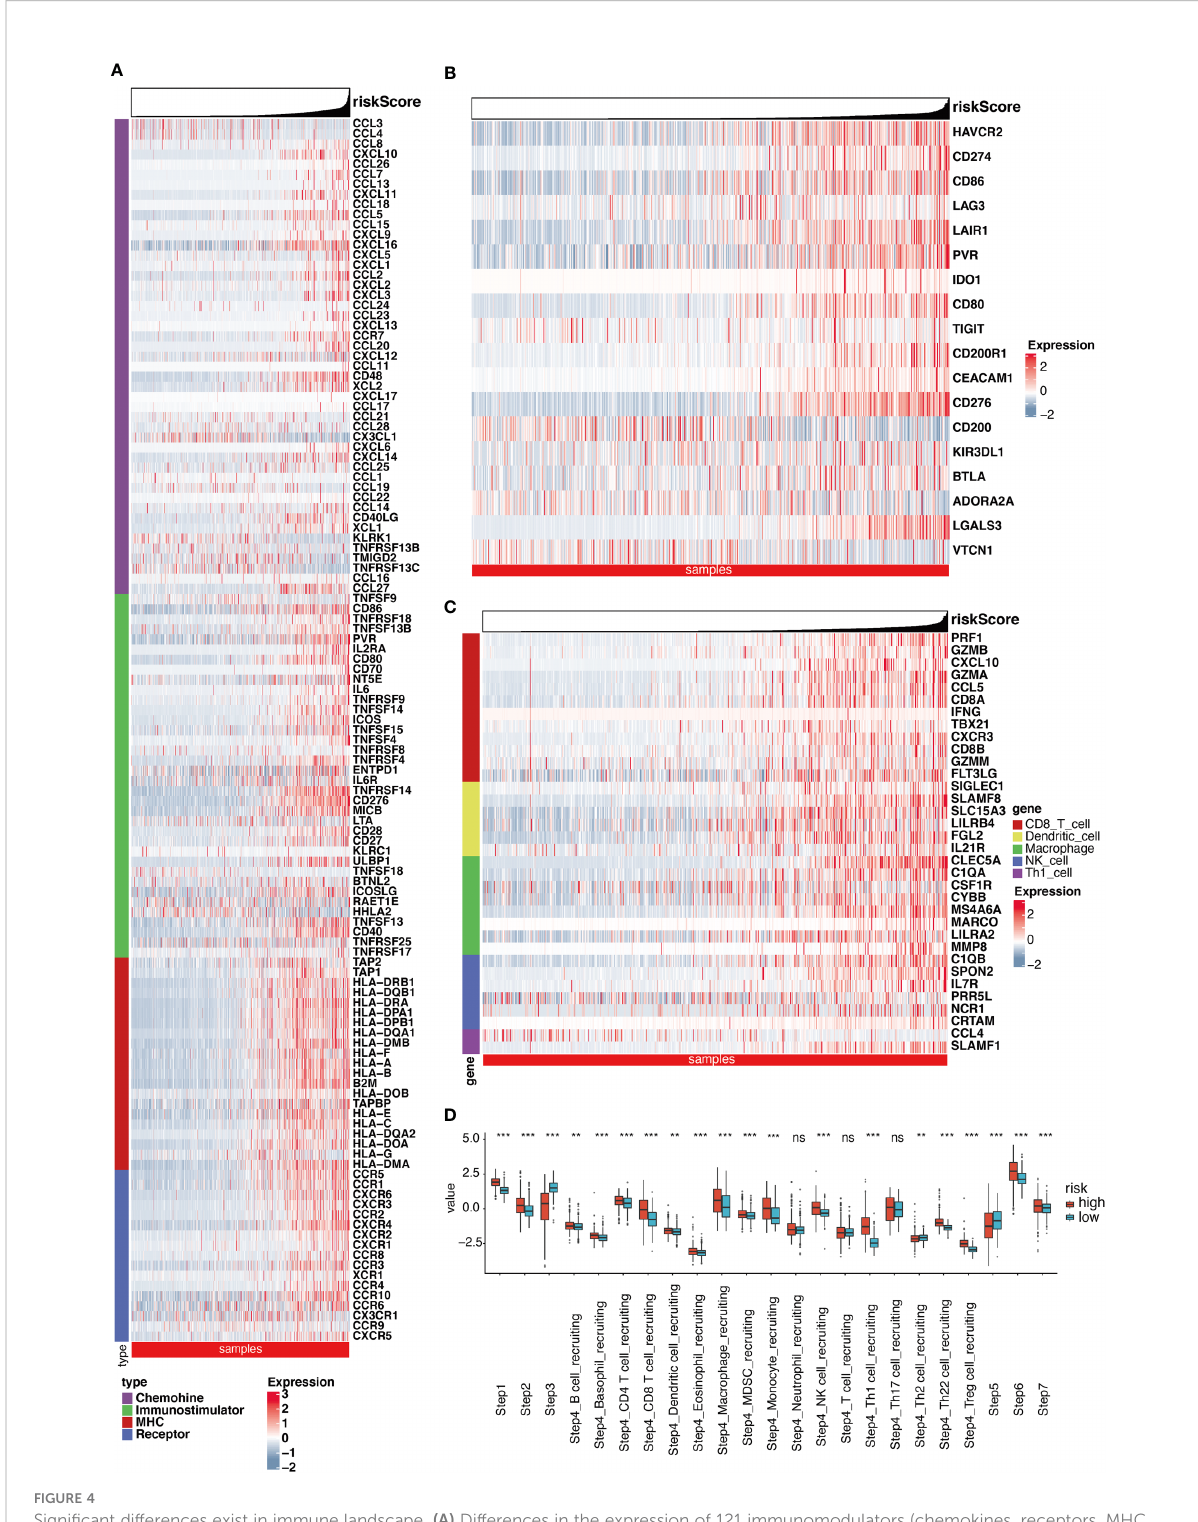
FIGURE 4 Signi fi cant differences exist in immune landscape. (A) Differences in the expression of 121 immunomodulators (chemokines, receptors, MHC, and immunostimulators) between high- and low-risk score groups in glioma. (B) Differences in the expression of 18 inhibitory immune checkpoints between high- and low-risk score groups in glioma. (C) Differences in the effector genes of the tumor-associated immune cells between high- and low-risk score groups in glioma. (D) Differences in the various steps of the cancer immunity cycle between high- and low- risk score groups. **P < 0.01, ***P < 0.001, ns non-signi fi